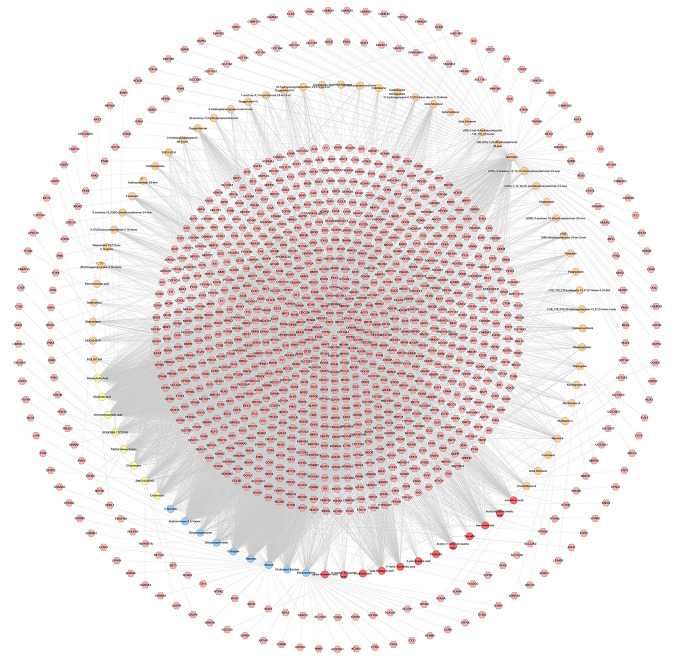
Potential compounds-potential targets network of XHP (The red circle stands for compound of Olibanum; the blue circle stands for compound of Moschus; the yellow circle stands for compound of Bovis Calculus; the orange circle stands for compound of Myrrha. The pink hexagon stands for potential targets.)